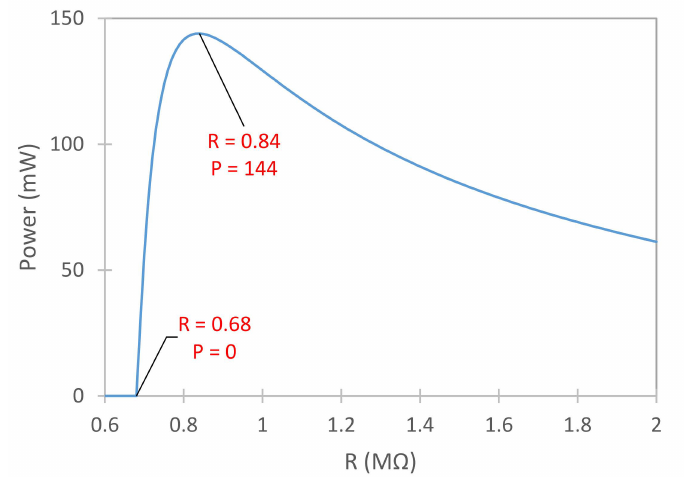
Figure 4. Graph Showing Variation of Power Output with Resistance R . For values of R between 550 k Ω and 680 k Ω , the onset velocity is larger than the flow velocity. The maximum power is observed at a resistance of 840 k Ω , beyond which a